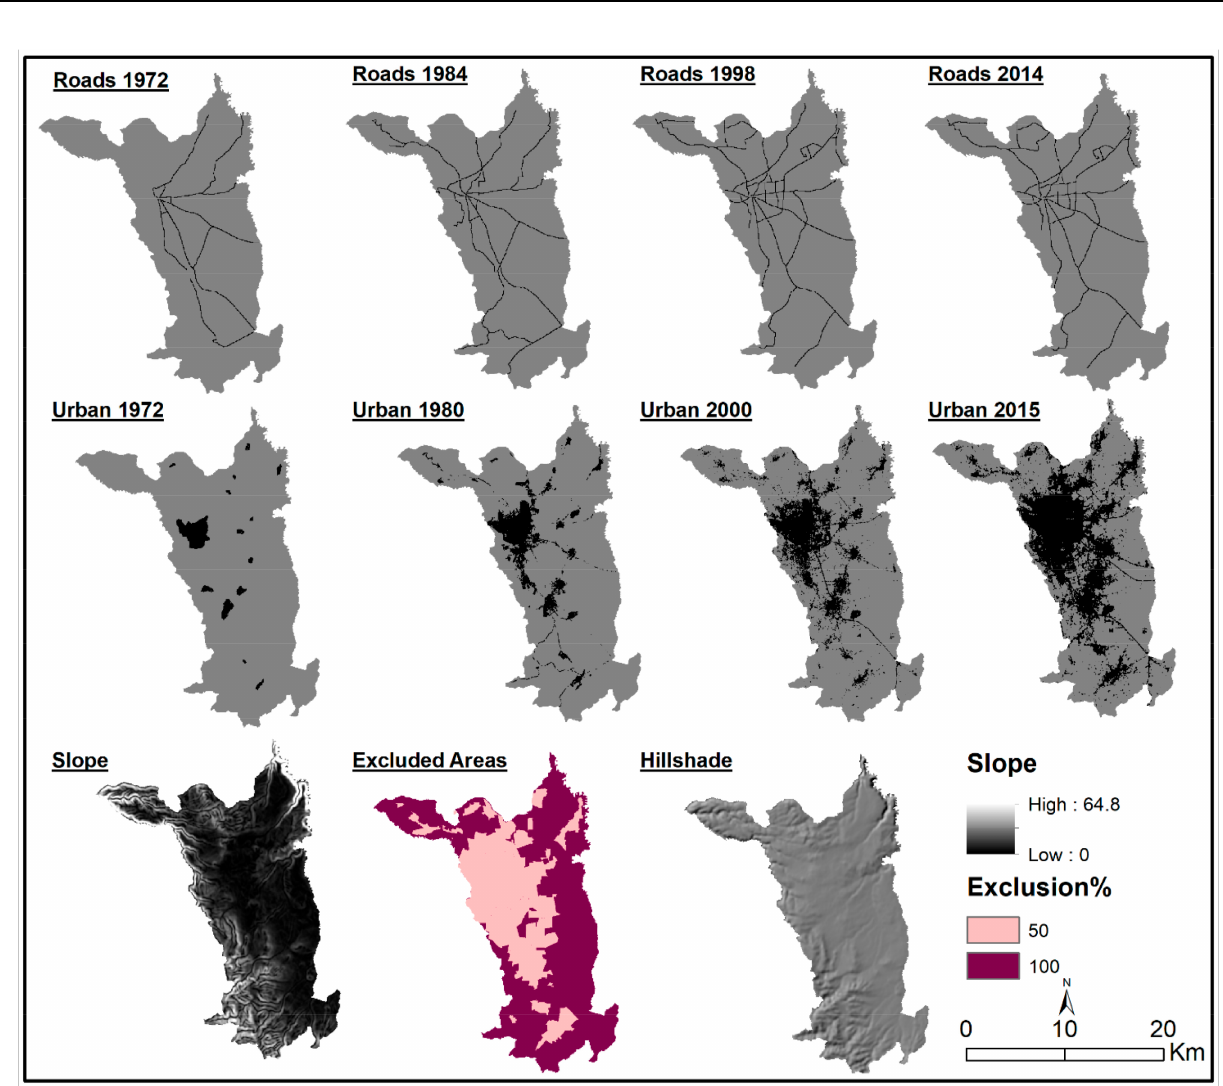
Figure 2. GIM inputs datasets to